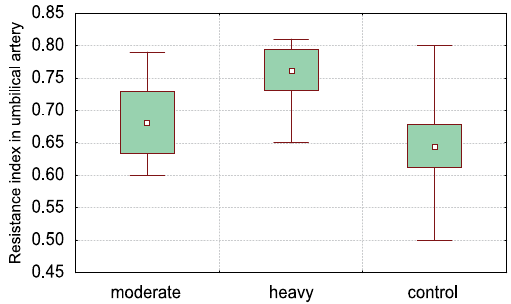
FIGURe 1. Mean, standard deviation, and upper and lower limits of data of resistance index values in umbilical artery in moderate, heavy and non-smokers (control) groups of preg- nant women